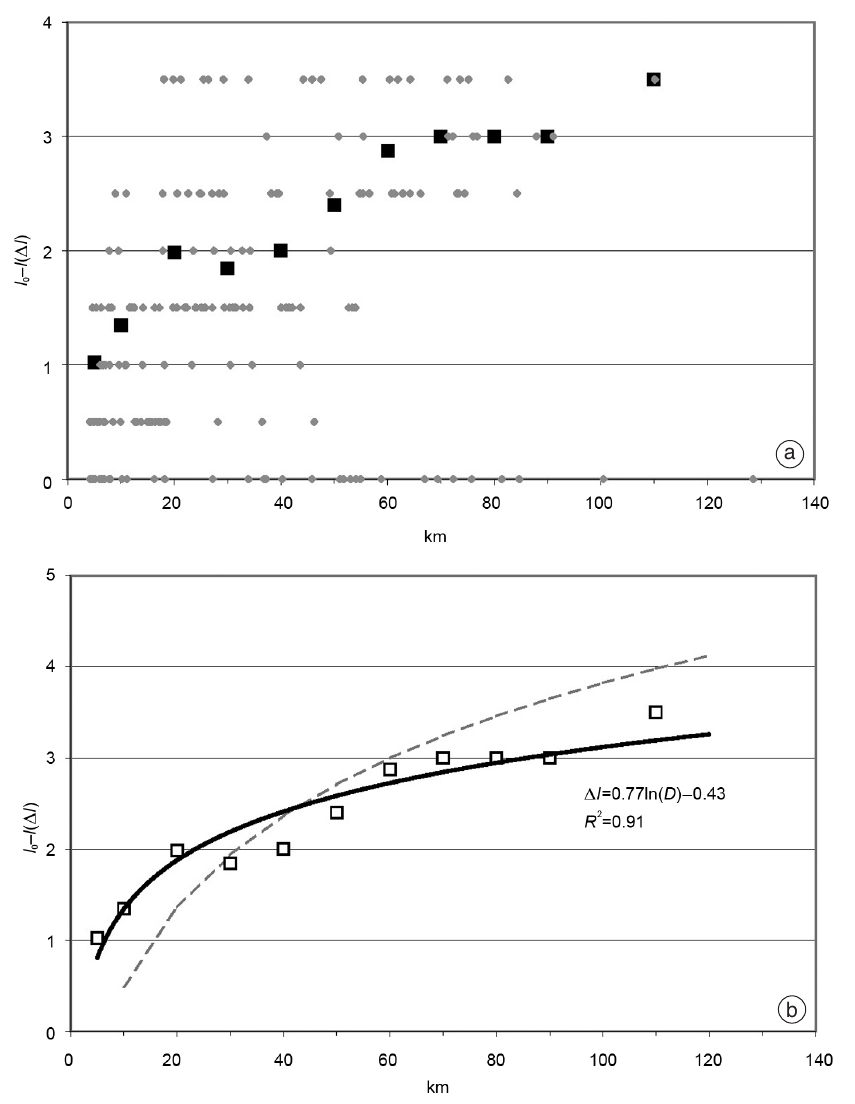
Fig. 12a,b. Albani Hills. a) Hypocentral distances versus ∆ I for the earthquakes used in the analysis (diamonds) and arithmetic average of ∆ I (squares). b) Logarithmic relationship for the average values and comparison with the Peruzza (2000) equation